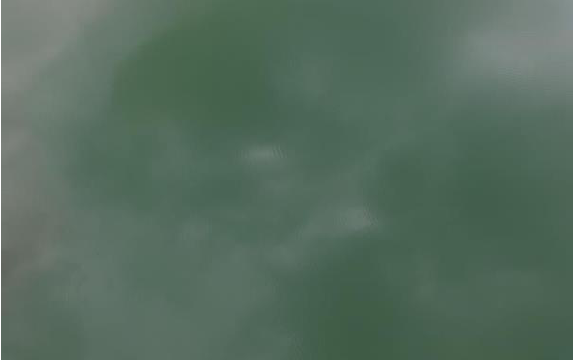
Figure 2 First measurement profile at Žermanice